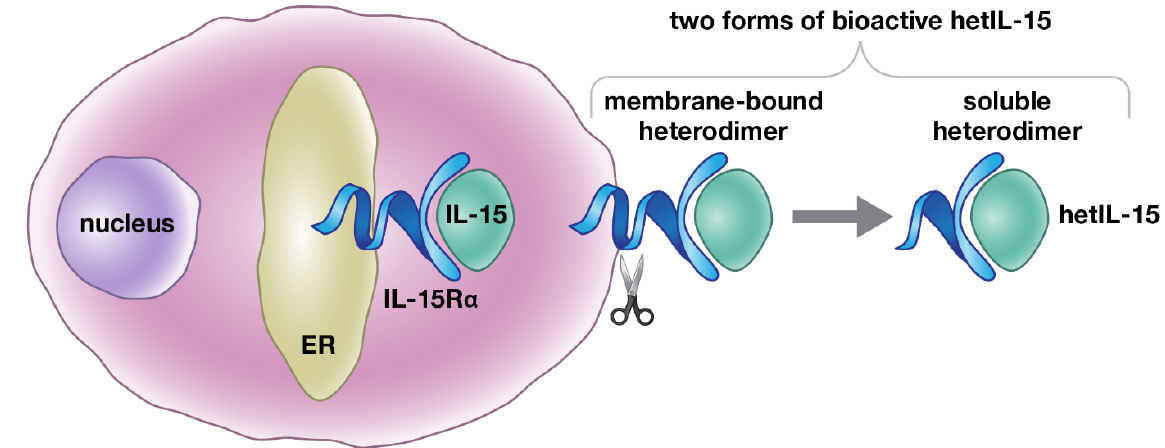
Figure 1. Schematic representation of hetIL-15 production. IL-15 is a heterodimeric cytokine, comprising the IL-15 and IL-15R α chains that are together termed heterodimeric IL-15 (hetIL-15). Simultaneous expression of IL-15R α in the same cells (dendritic cells, monocyte/macrophages, and others) is necessary for the production and secretion of IL-15 under physiological conditions. Upon co-expression, the two chains, IL-15 and IL-15R α , associate in the endoplasmic reticulum (ER), due to their high binding affinity (K d = 10 − 11 M). The IL-15 heterodimer is then transported to the cell surface and released as a bioactive soluble heterodimeric molecule, upon proteolytic cleavage of IL-15R α .